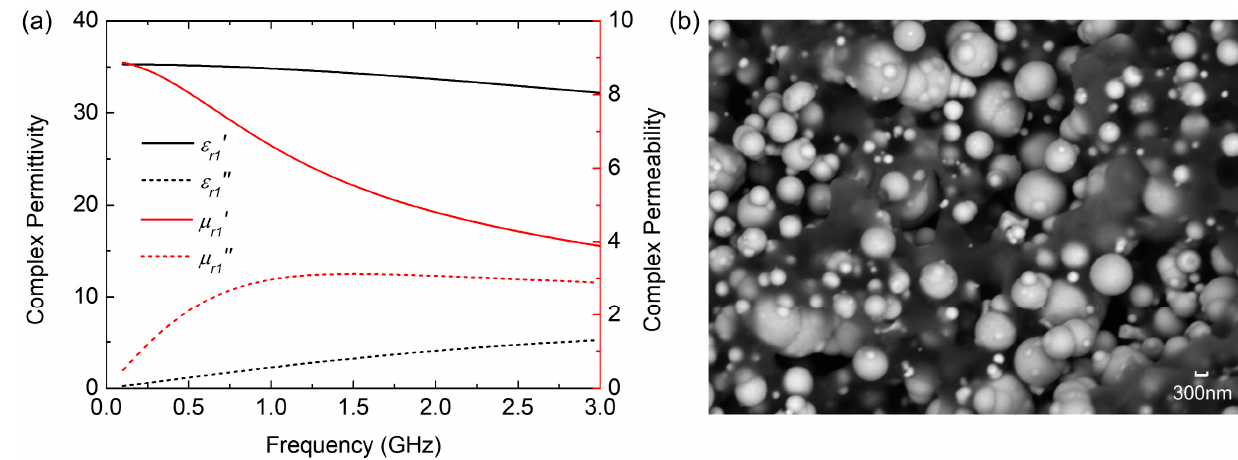
Figure 1. ( a ) The EM parameters of the magnetic nanomaterial. ( b ) The SEM image of the magnetic nanomaterial.